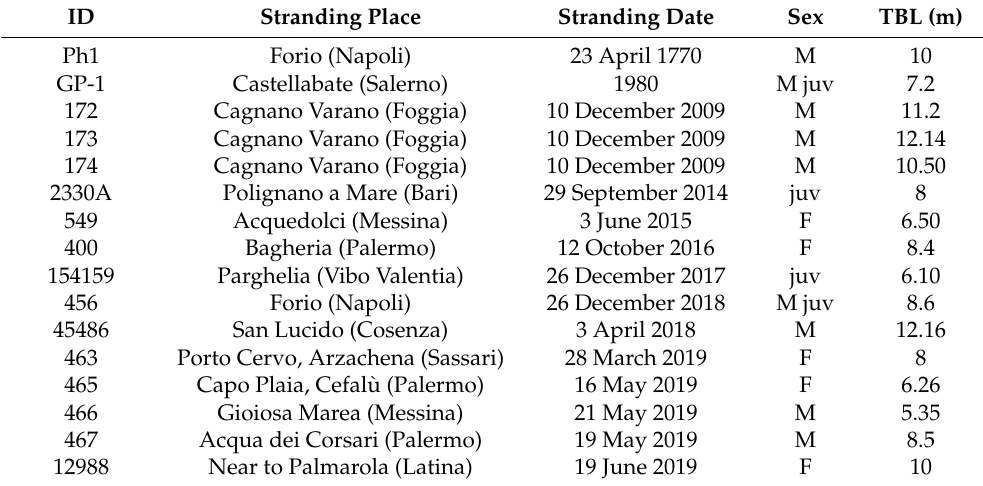
Table 1. Specimens of P. macrocephalus used in this study. F: female; Juv: juvenile; M: male; TBL: total body